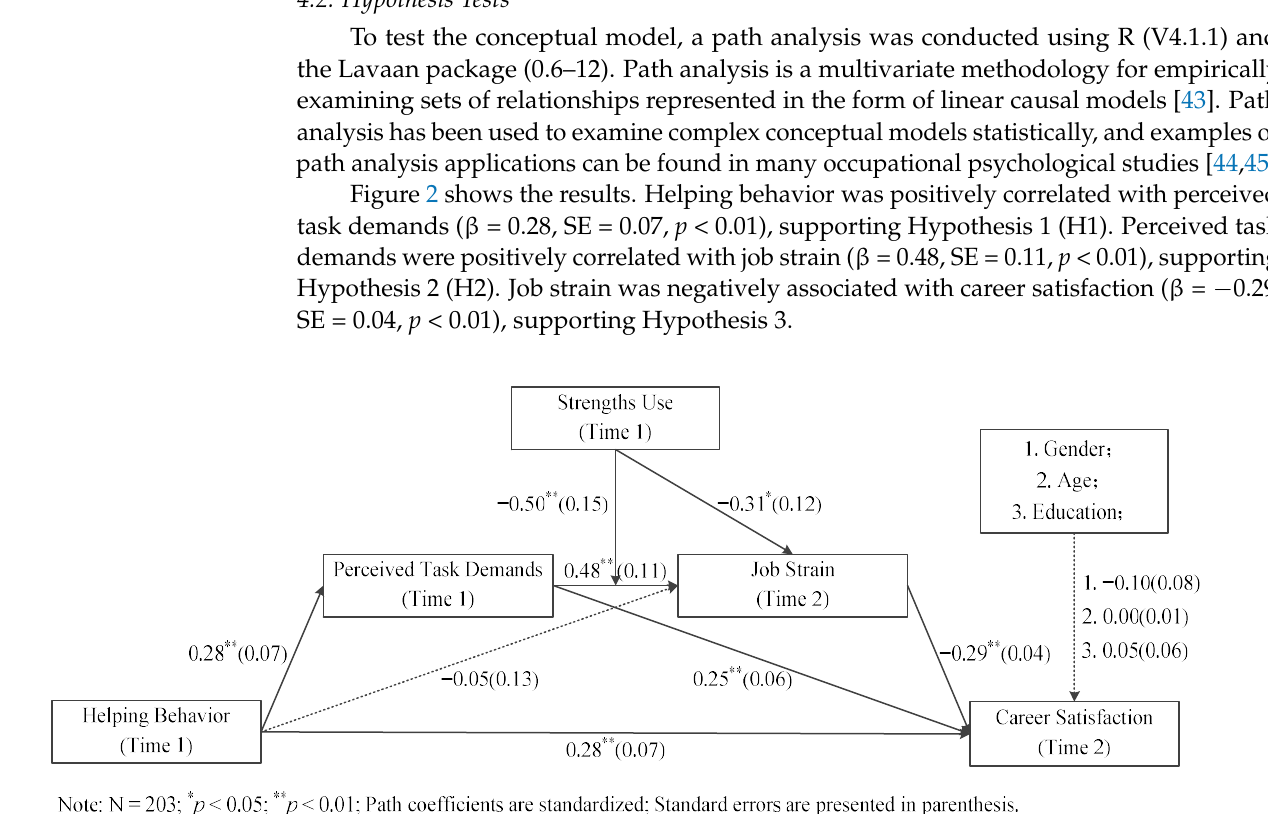
Figure 2. Results of path analysis.